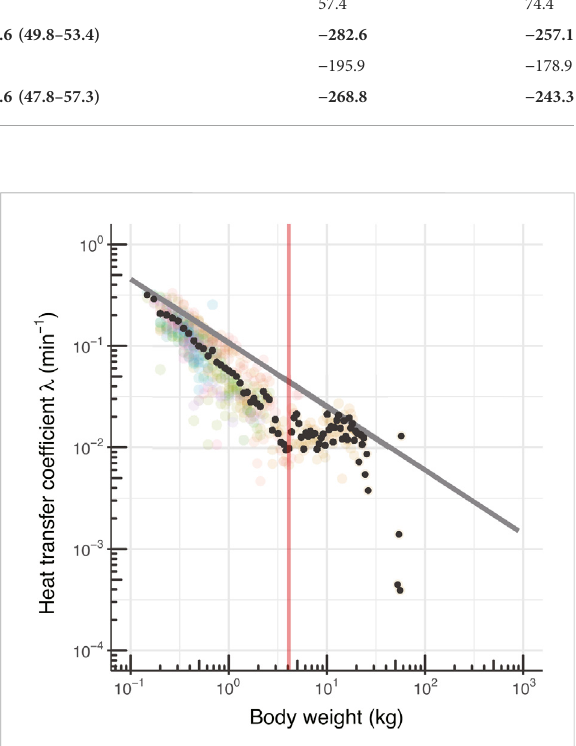
FIGURE 7 Relationship between body mass and heat-transfer coef fi cients λ of juvenile PBT. Black- fi lled circles and colored transparent circles represent the mean value and each individual value of λ , respectively. The red vertical line indicates the breakpoint of body size (52 cm) of λ in Figure 5. The body-size scalingof λ estimatedbyapreviousstudy(Nakamuraetal.,2020)is indicated by the bold gray